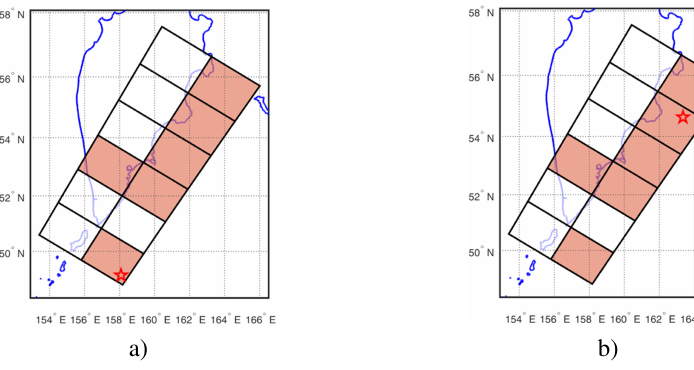
Figure 6. Maps of expectation area S exp for earthquakes: a) 25.03.2020, K S = 16 . 8; b) 16.03.2021, K S = 14 . 6. Red stars on the map are earthquake